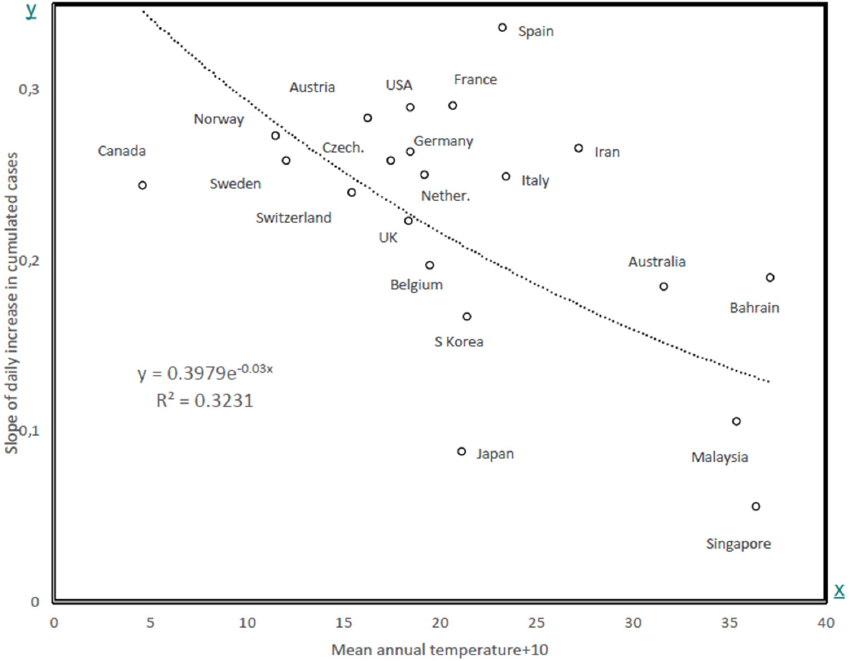
Figure 4. Slope of exponential model fitted to data in Table 3 as a function of mean annual temperature in that country. The Pearson correlation coefficient is R = − 0.568, one-tailed p = 0.0036.